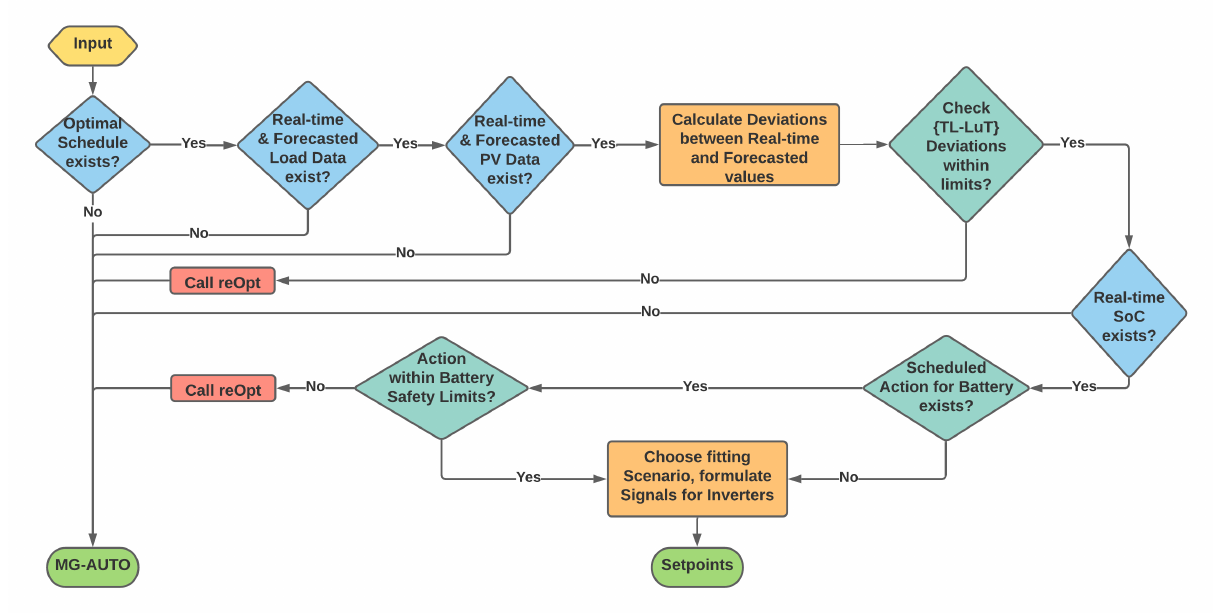
Figure 2. Logical flow chart of the RT-VAOS